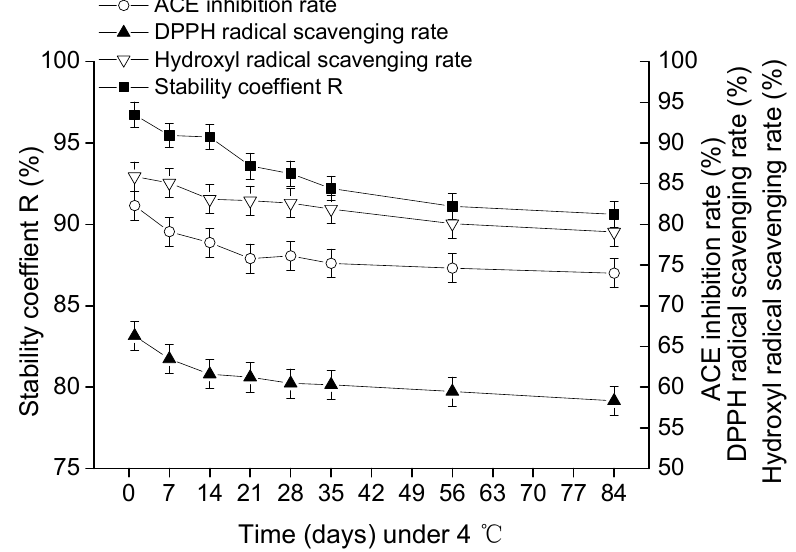
Figure 6. The storage stability, ACE-inhibitory activity, and antioxidant activity in goat milk catalyzed by CEP of L. plantarum LP69 at 4 °C. The error bars represent standard deviation of means ( n = 3).